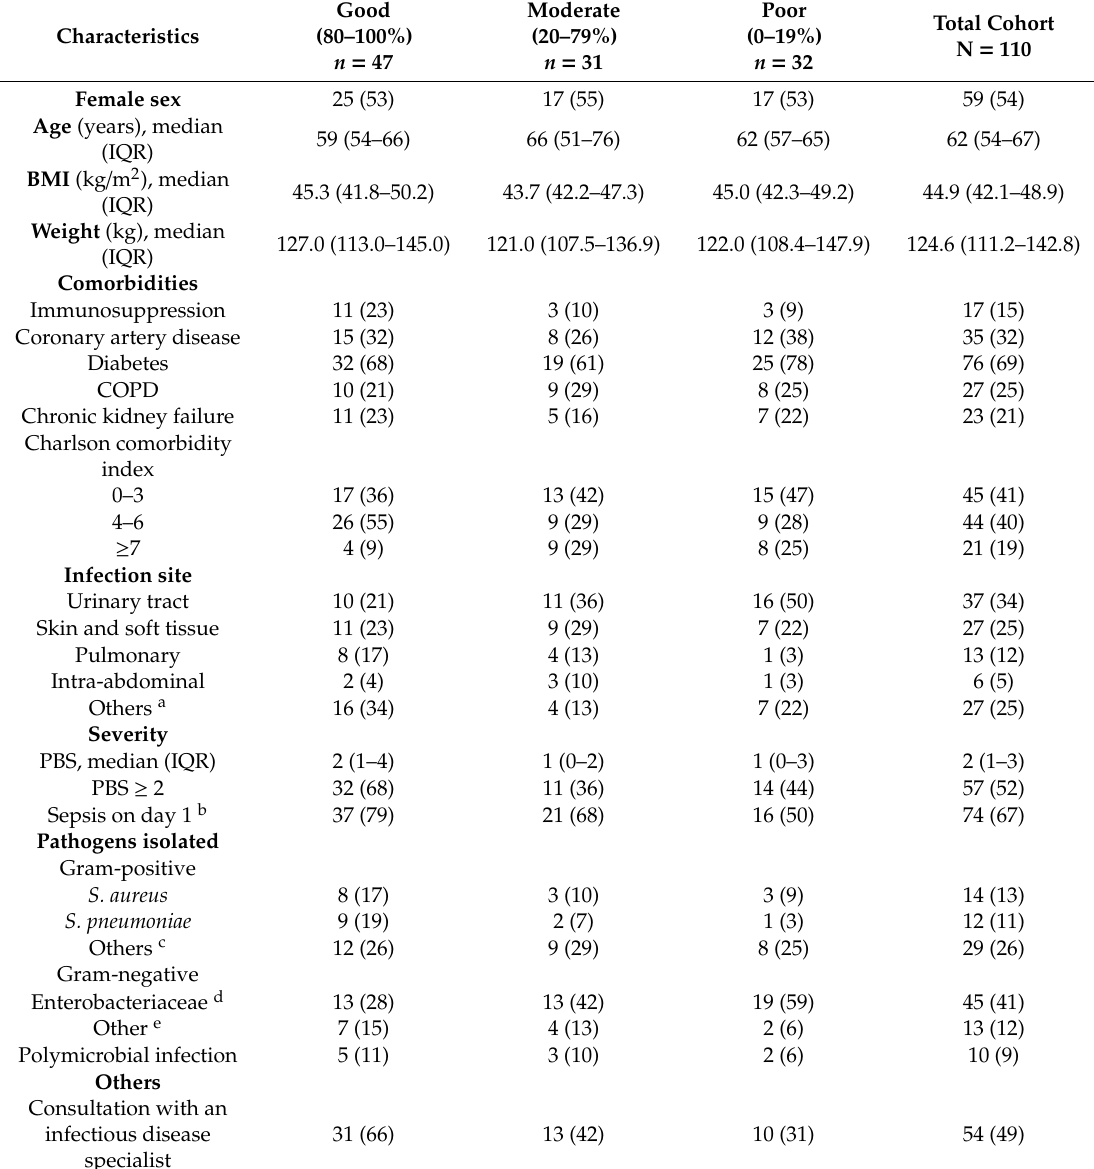
Table 2. Patient demographics and medical conditions stratified by the level of appropriateness.